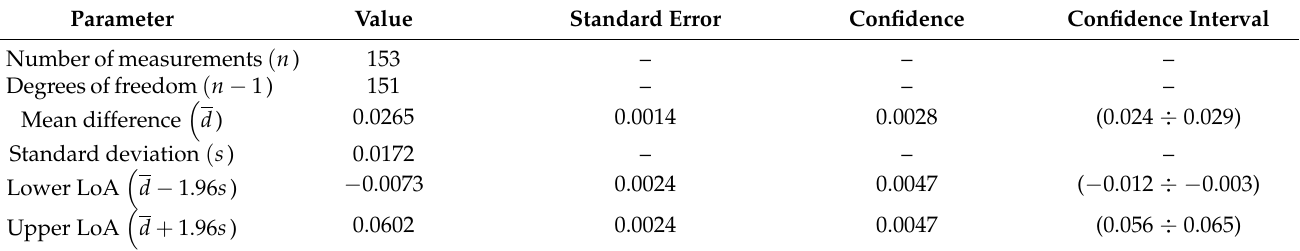
Table 4. Bland and Altman plot statistics (right side of arch support frame).